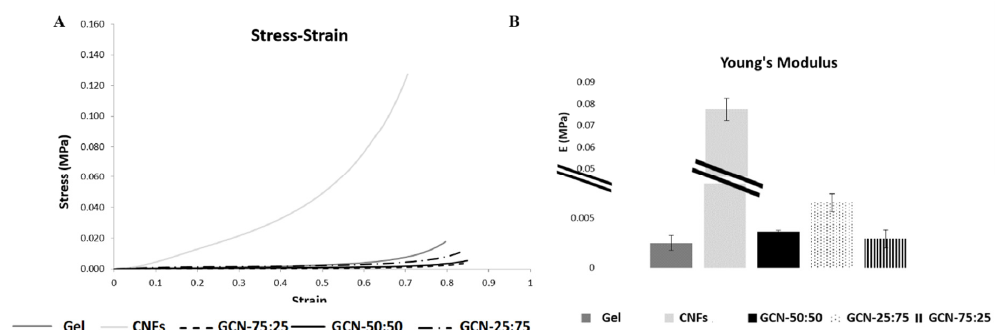
Figure 5. Compressive mechanical test of Gel–CNF biocomposites after soaking in phosphate buffered saline (PBS) at 37 °C overnight. ( A ) Average stress-strain curves ( n = 5 specimens); ( B ) Young’s modulus calculated as the slope of the stress-strain curve in the strain range of 0.01-0.10 ( n = 5 specimens).